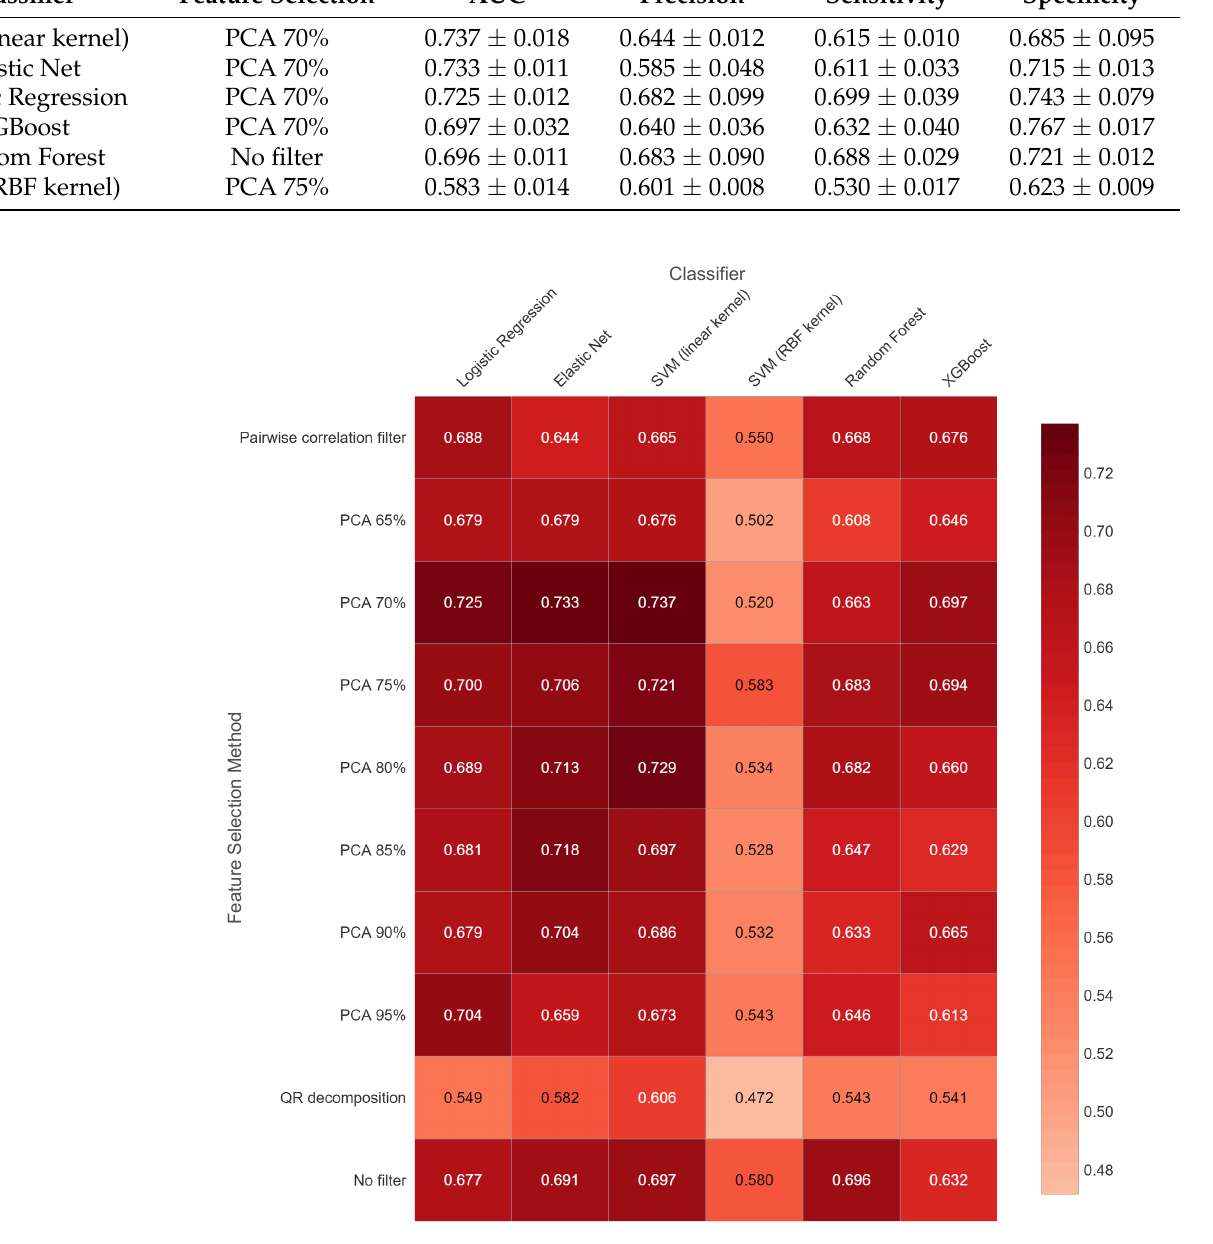
Figure 3. Heatmap with the AUC of each classifier/feature selection combination. Dark colors stand for the best results, while light colors represent the worst